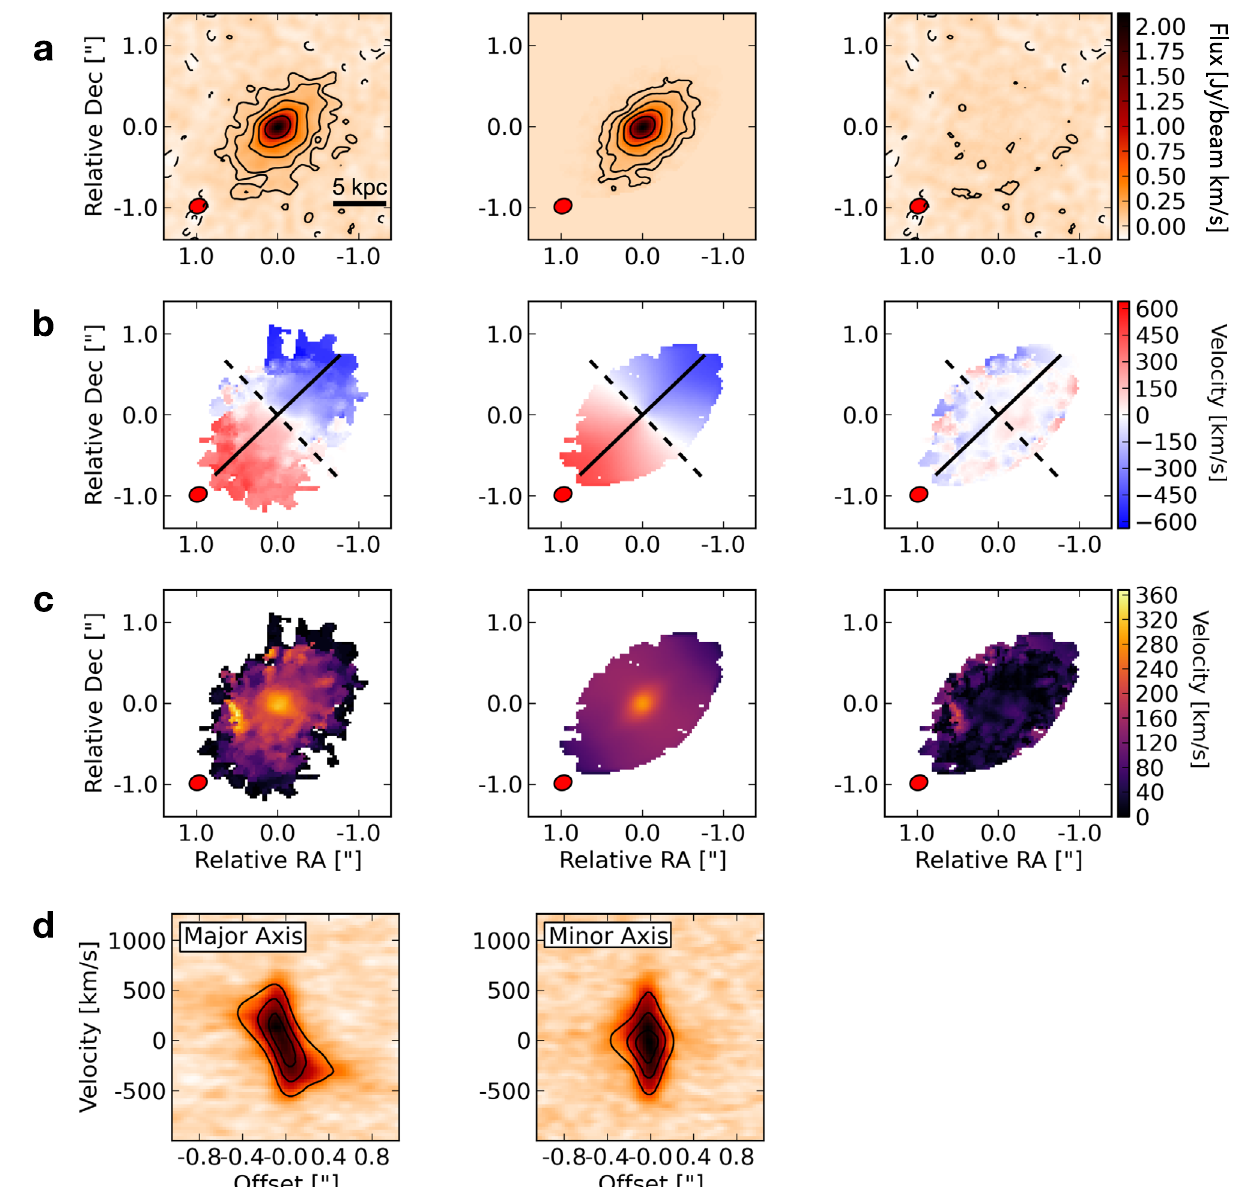
Fig. 9 | Moment maps of ALMA CO(6-5) observations compared with the 3D Barolomodels. Inpanel a , b , c ,weshow themoment-0,moment-1,andmoment 2oftheCO(6-5)data.Foreachofthesepanels,thethreecolumnsdenote(fromleft toright)theobserveddata,models(created with 3D Barolo),andthecorresponding residuals.Theblacksolidlineinthelower-leftcornerofthemoment-0panelshows a 5kpc physical scale. The solid lines in the second row represent the kinematic